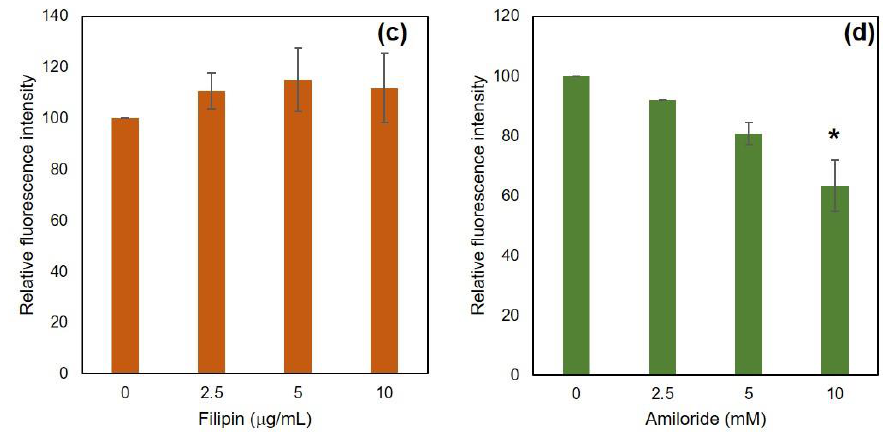
Figure 3. Interaction of DLPC/deoxycholic acid micelles with DC2.4 cells. ( a ) Effects of temperature for cellular association of micelles. DC2.4 cells were treated with Rh-PE-labeled micelles for 5 h at various temperatures. Cellular fluorescence was measured using a flow cytometer. ( b – d ) Effect of inhibitors for cellular association of micelles. Cellular association of Rh-PE-labeled micelles in the presence of various amounts of indicating inhibitors was evaluated. * p < 0.05 for the groups without